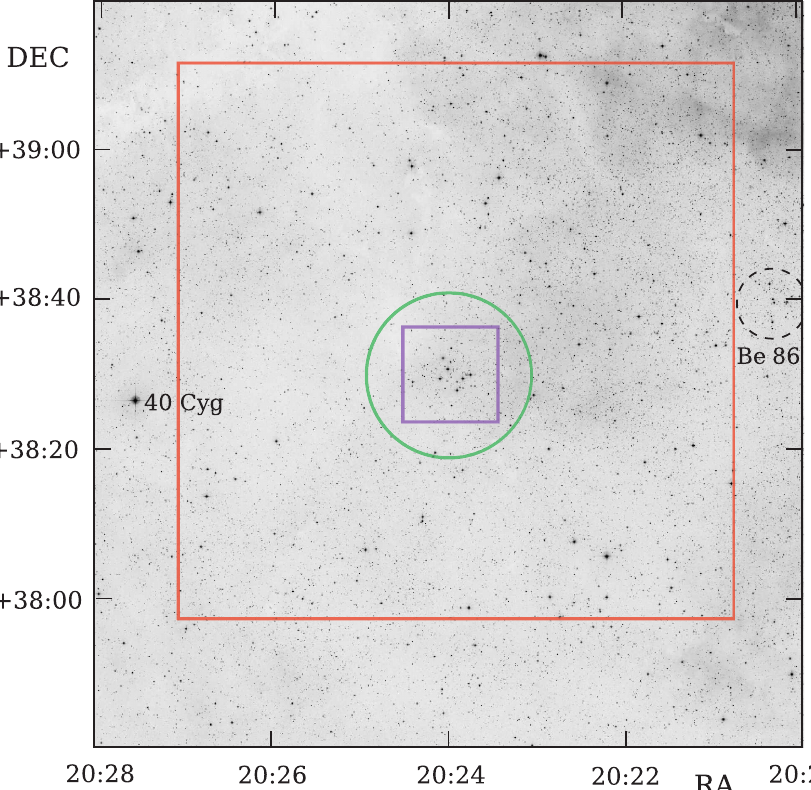
Fig. 1. Approximate positions of the three CCD fields used for stellar photometry around the cluster M29. The background image is the DSS2 Red image from SkyView. The Maksutov telescope field (the (cid:24) 1.25 ◦ square) is shown in red, the Flagstaff telescope field (diameter 22 ′ ) is shown in green and the VATT field (13 ′ square) is shown in violet. The star 40 Cyg and the cluster Berkeley 86 are